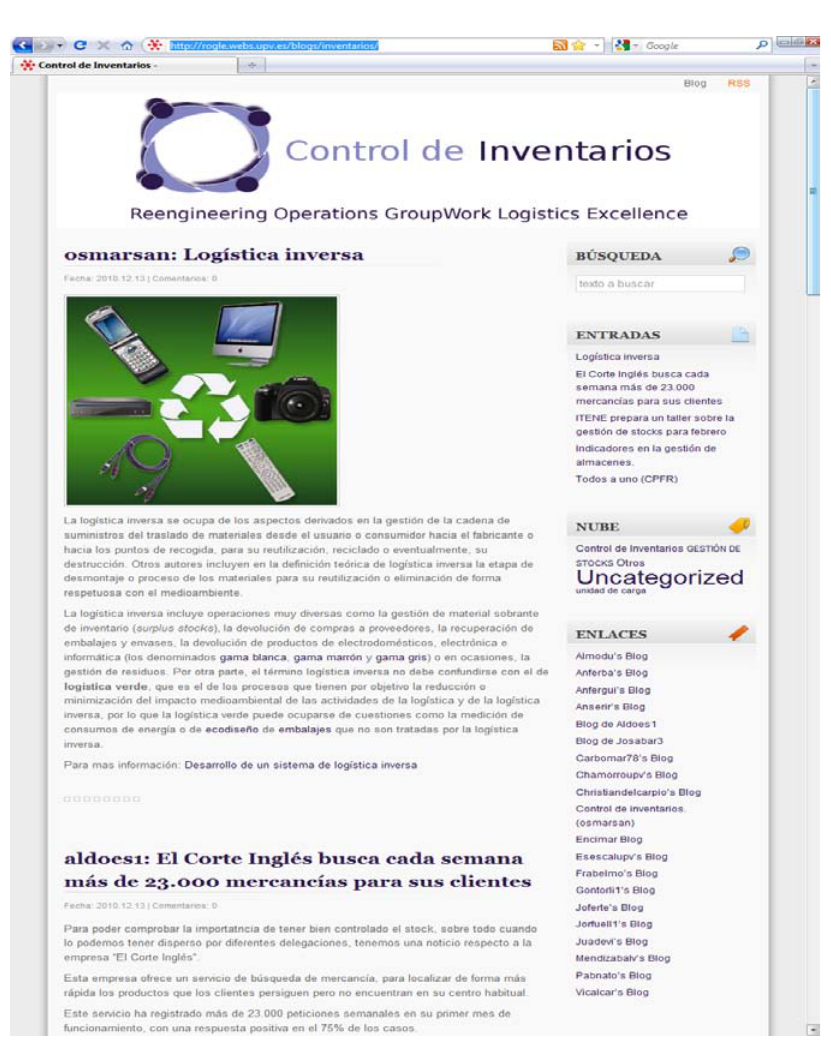
Figure 3. “Overview of a